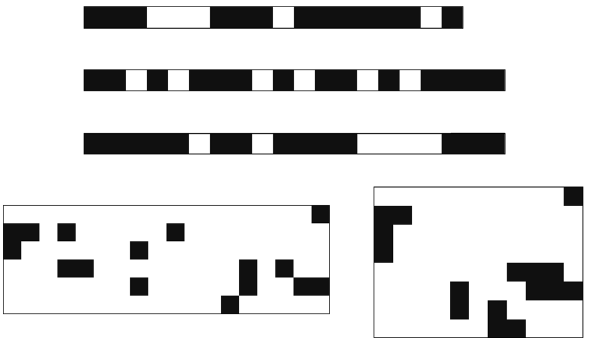
Figure 4. Typical energy clusters of the random TIM. A unit square is assigned to each site: black (white) squares denote non-decimated (decimated) spins. Top: energy clusters at �θ = ln 2 for d = 1 chains with L = 32, 768 . The clusters are ℓ = 18 ; 20 ; 20 in length and µ = 13 ; 14 ; 14 in mass from top to bottom. Bottom: energy clusters with a bounding box at �θ = 0.5 for d = 2 with L = 4, 096 . The left (right) cluster have a linear extension (longer edge of the bounding box) ℓ = 18 ( 11 ) and a mass µ = 16 ( 16 )